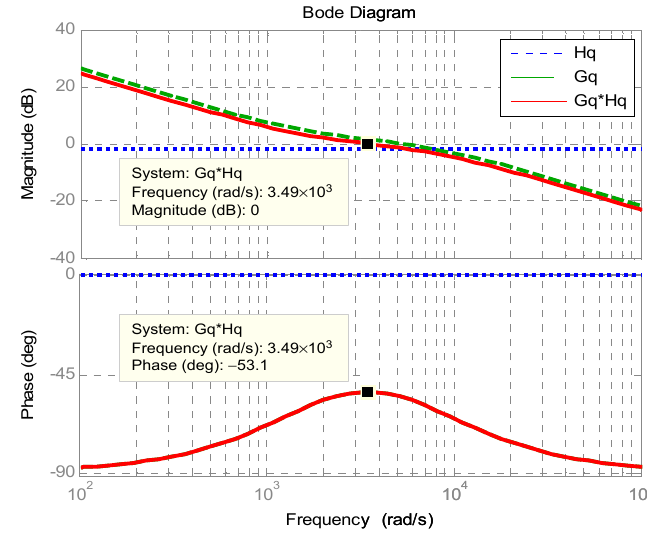
Figure 11. Bode plot of outer reactive power control loop.